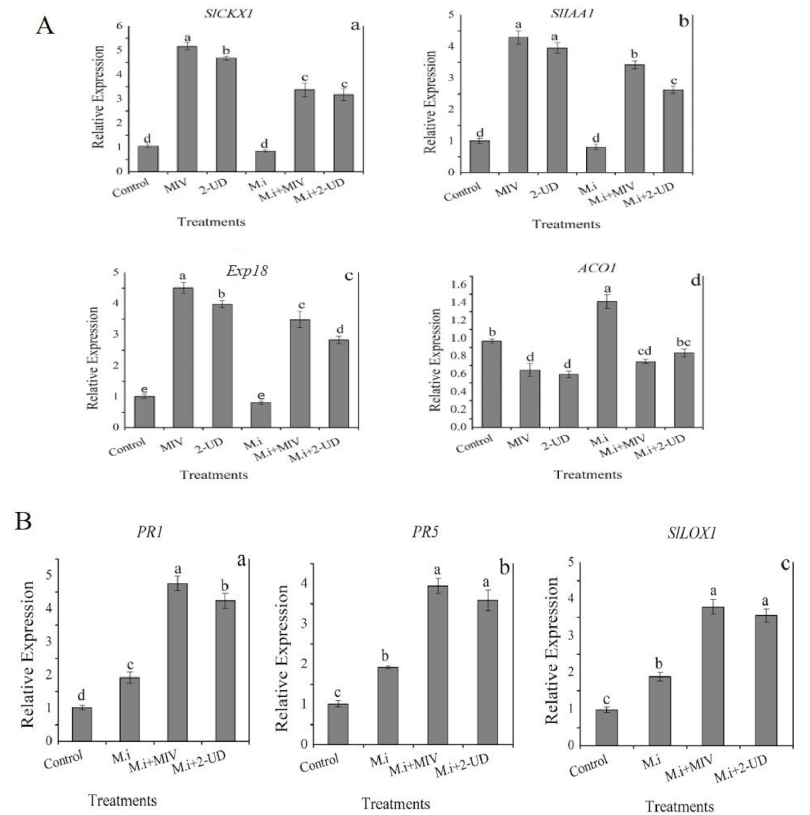
Figure 10. ( A ) Expression analysis of growth-promoting genes ( a ) SlCKXI , ( b ) SlIAA1, ( c ) Exp18 , and ( d ) ACO1 ) in M. incognita (M. i)-infested tomato plant at 5 dpi pre-exposed to pure volatiles, i.e., MIV and 2-UD. ( B ) The expression profile of defense-related genes ( a ) PR1 , ( b ) PR5 , and ( c ) SlLOX1 in M. incognita -infested plants pre-exposed to MIV and 2-UD as compared with healthy control. The error bar indicates the mean standard deviation of each treatment repeated three times with three replicates. The different small letters above the columns indicates significant difference according to Tukey’s HSD test at p ≤